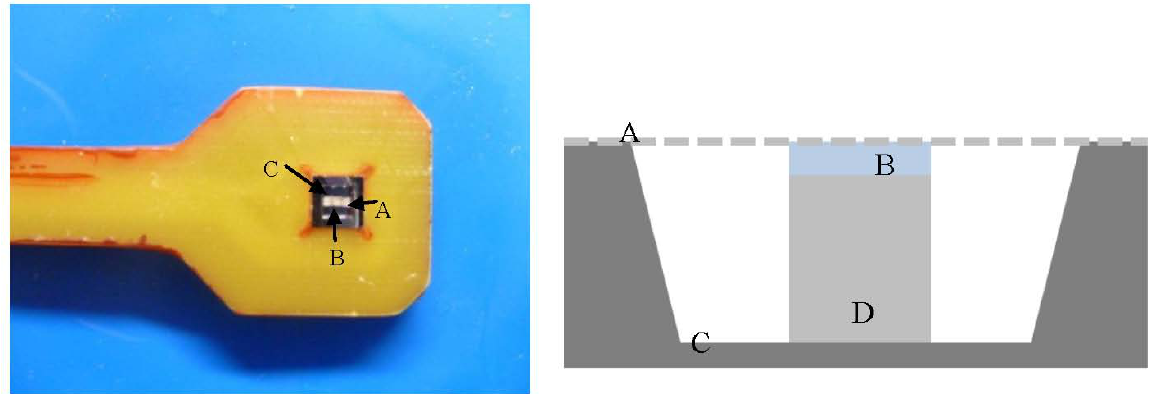
Figure 2. The image on the left shows the actual microsensor assembly. The image on the right shows a cross sectional illustration of the sensor assembly. In the image ( A ) is the mesh membrane, ( B ) is the hydrogel sample, ( C ) is the piezoresistive diaphragm, and ( D ) is the